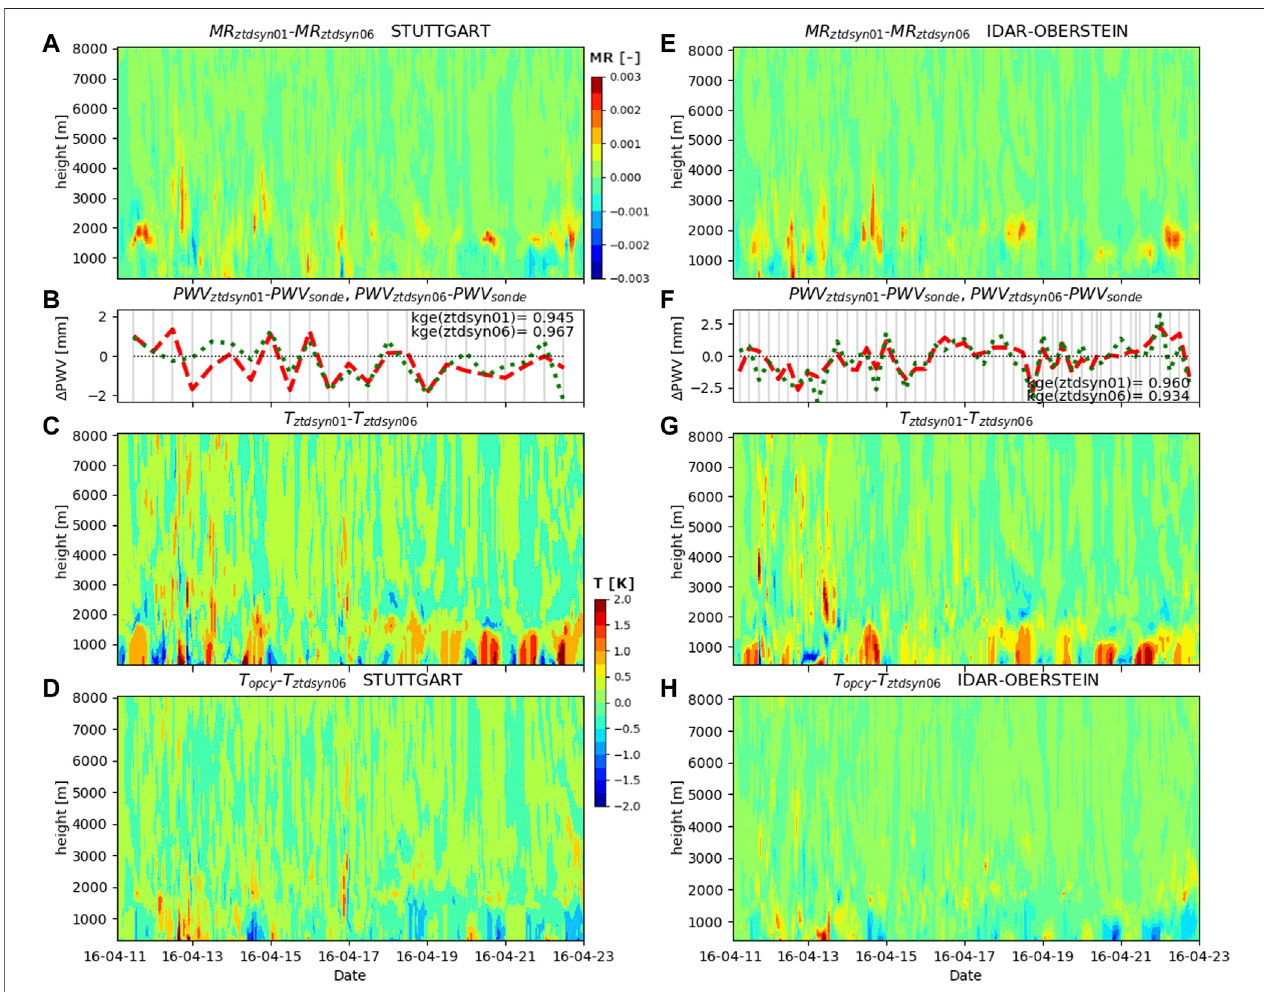
FIGURE 5 | Difference of the mixing ratio (MR) with height (A) and temperature (T) (C) for the combined assimilation of ZTD and synoptic data at the Stuttgart location with 1 h (red) and 6 h (green) resolution for the spring episode and difference of corresponding PWV values and radiosonde data (B) . (D) shows the respective comparison of the open cycle run and the combined assimilation of ZTD and synoptic data with 6 h cycling rate for temperature. (E – H) are the respective comparisons for Idar-Oberstein.